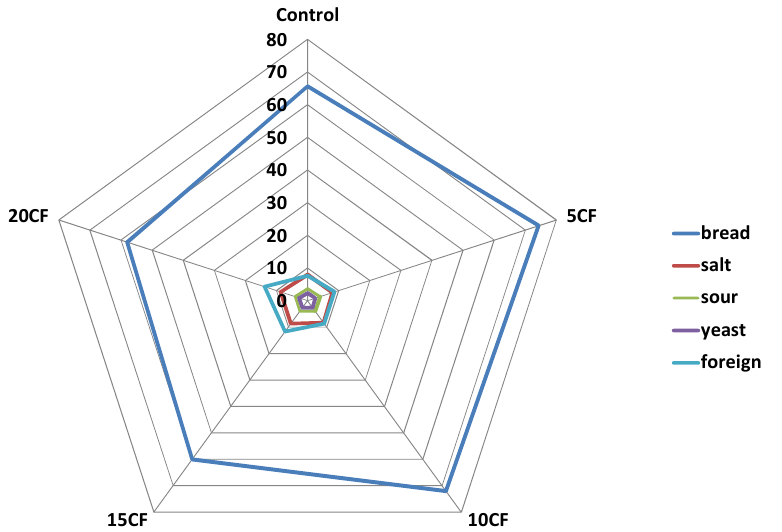
Figure 5. The taste of gluten-free bread with the addition of chestnut flour in the amount of 5% (5CF), 10% (10CF), 15% (15CF) and 20% (20CF).